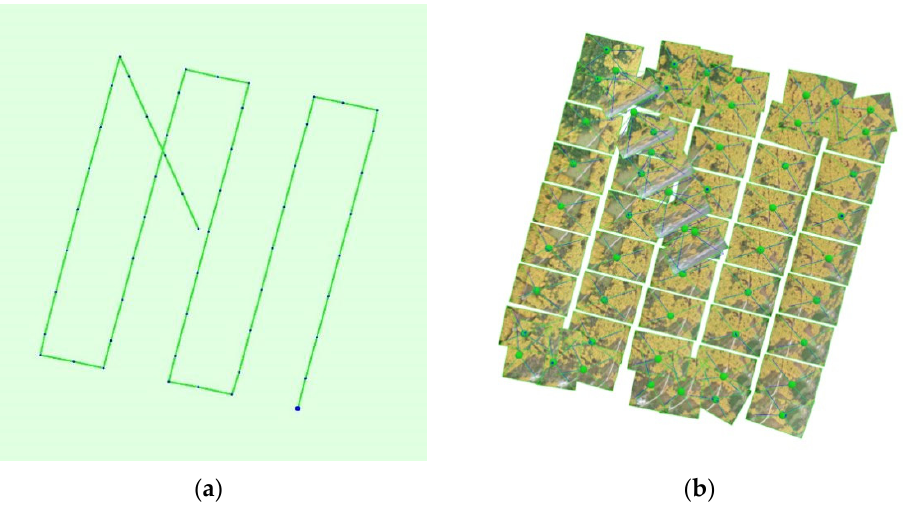
Figure 3. UAV flight trajectory ( a ) and trajectory images ( b ).